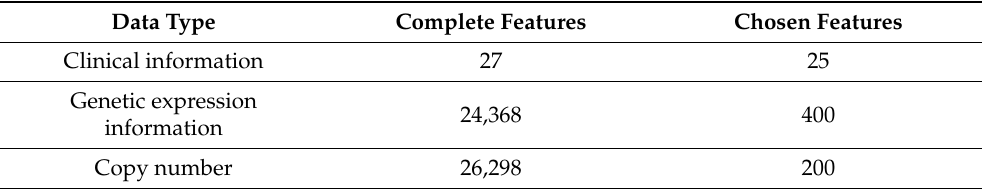
Table 2. Dataset